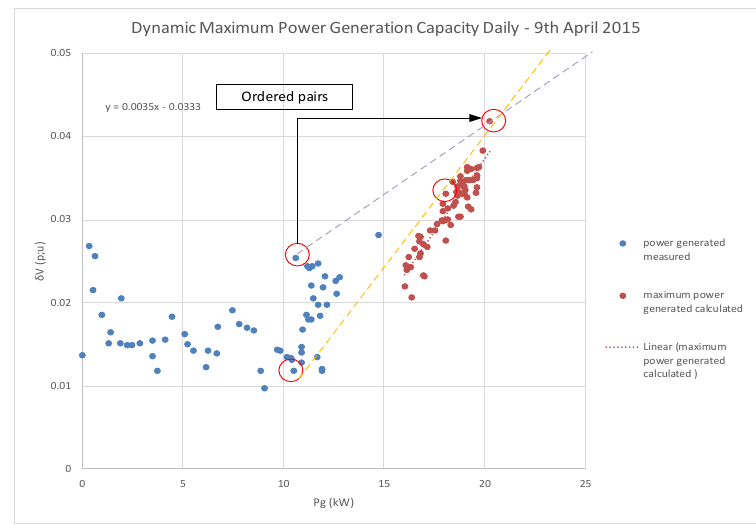
Figure 8. Exemplification of calculation of dynamic daily hosting capacity in relation to April 9th, 2015.